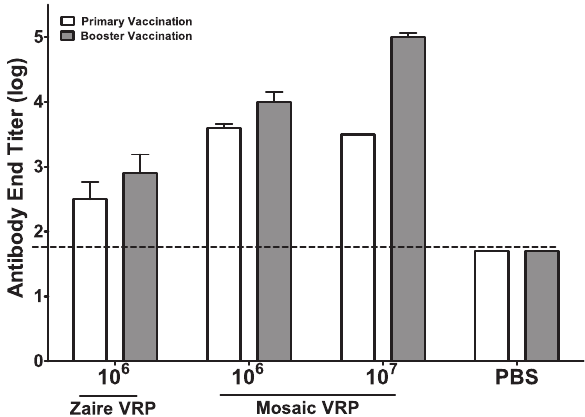
Figure 5. End-point murine IgG antibody titers measured by ELISA. Log antibody (IgG) end titers from female C57BL/6 mice. End titers are against recombinant Zaire virus GP measured by ELISA. The bar graphs show end titers after vaccination with 2 ? 10 6 plaque-forming units (pfu) of a virus-like replicon particle (VRP) expressing Mayinga strain Zaire virus GP; 2 ? 10 6 and 2 ? 10 7 pfu of VRP expressing the a GP mosaic protein; and phosphate-buffered saline (PBS). The mosaic protein is the most Zaire-like from the 4-protein mosaic Ebola virus GP cocktail designed against the original set. White bars show end titer after primary vaccination, grey bars show end titer after a 28-day delayed boosting vaccination. The dotted line is the ELISA cut-off as defined in the text.